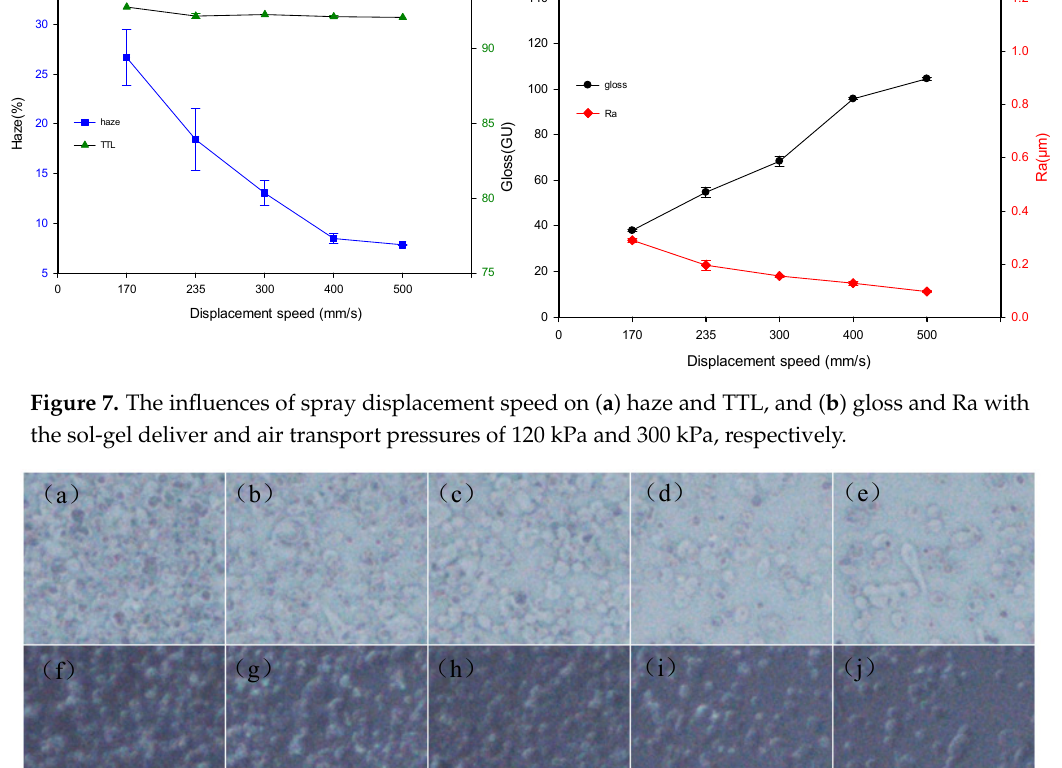
Figure 7. The influences of spray displacement speed on ( a ) haze and TTL, and ( b ) gloss and Ra with the sol-gel deliver and air transport pressures of 120 kPa and 300 kPa, respectively.